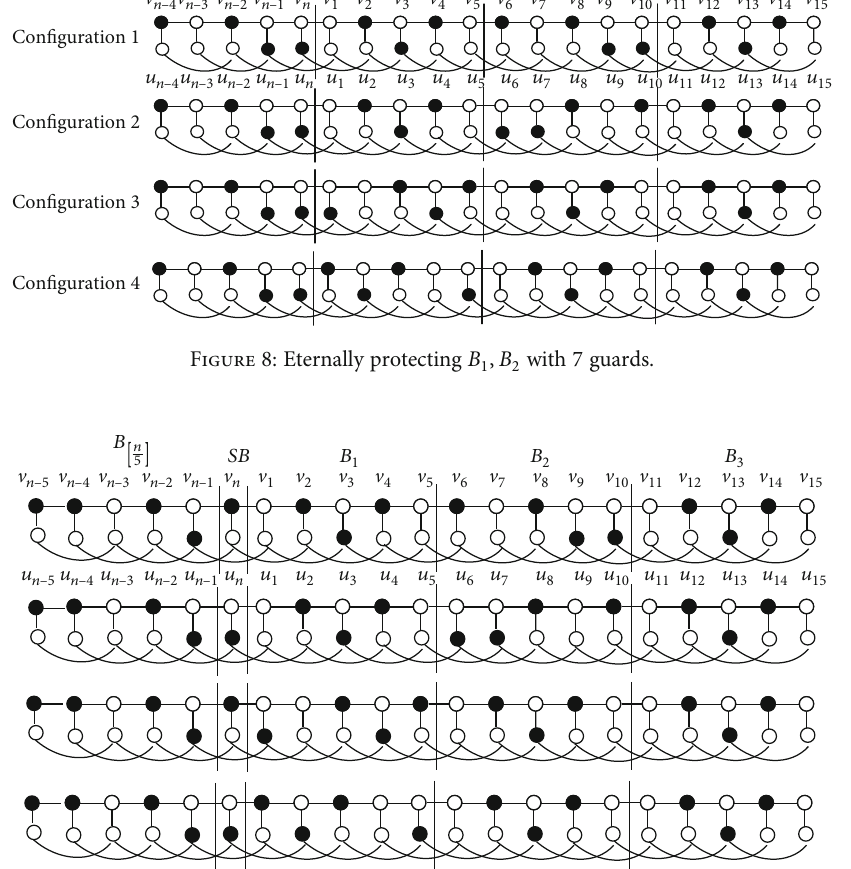
Figure 9: Eternally protecting B